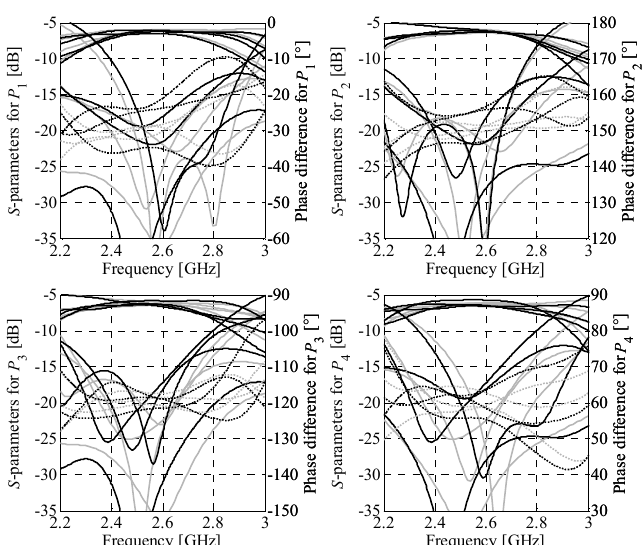
Figure 12. Butler matrix 1: comparison of the EM model responses obtained using CST Studio (gray) and Keysight ADS (black). Solid and dotted lines represent magnitude and phase responses, respectively.